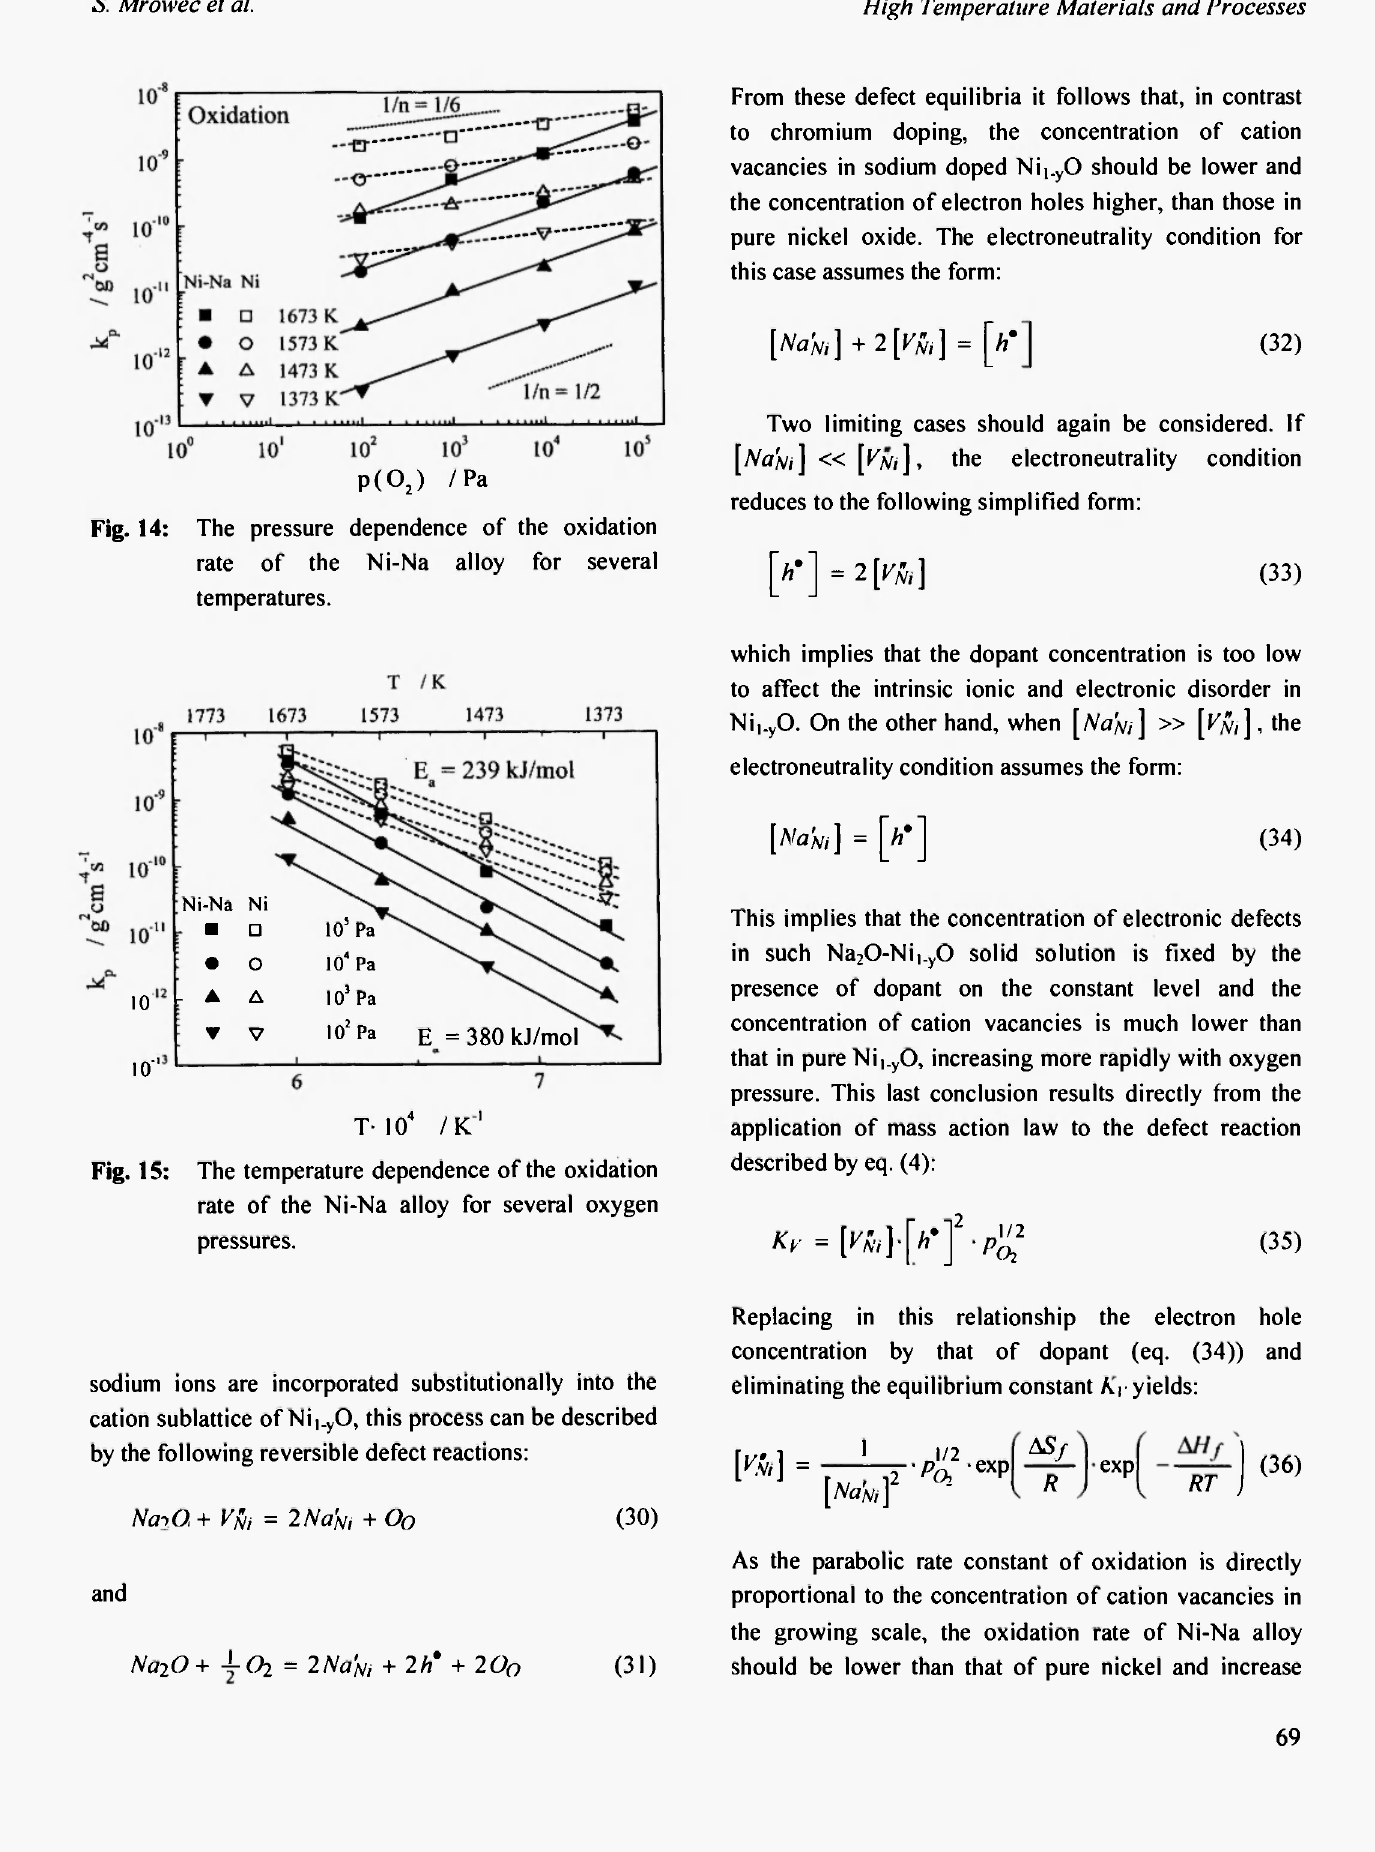
The pressure dependence of the oxidation rate of the Ni-Na alloy for several temperatures.